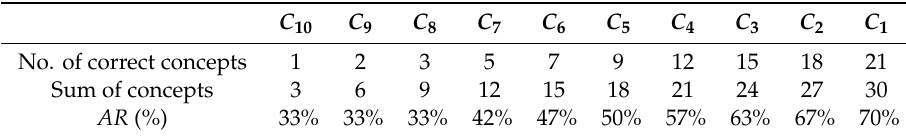
Table 8. Learning achievement results for student 1, who correctly answered Q 1 –Q 13 , Q 15 –Q 17 , Q 19 , Q 20 , Q 24 , Q 25 , and Q 30